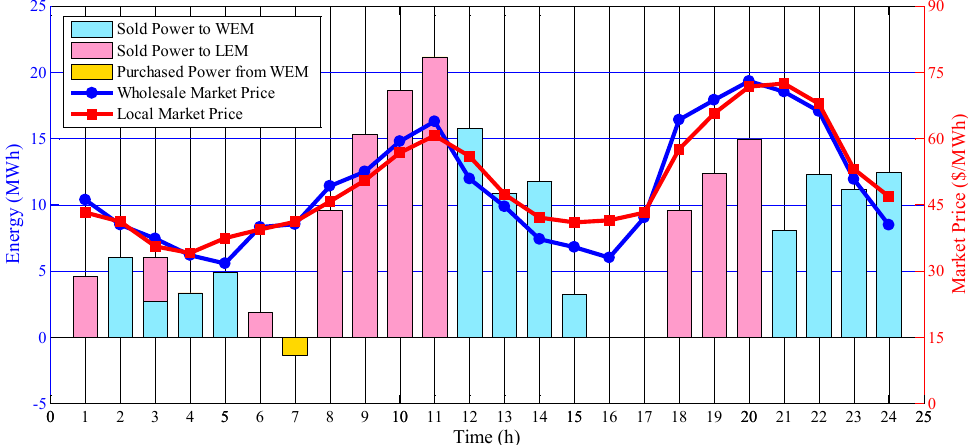
Figure 11. AG’s traded energy with markets in the DA stage considering the competitive environment.